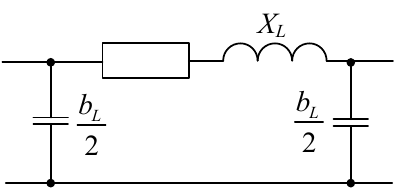
Figure 4. TVR equivalent circuit.